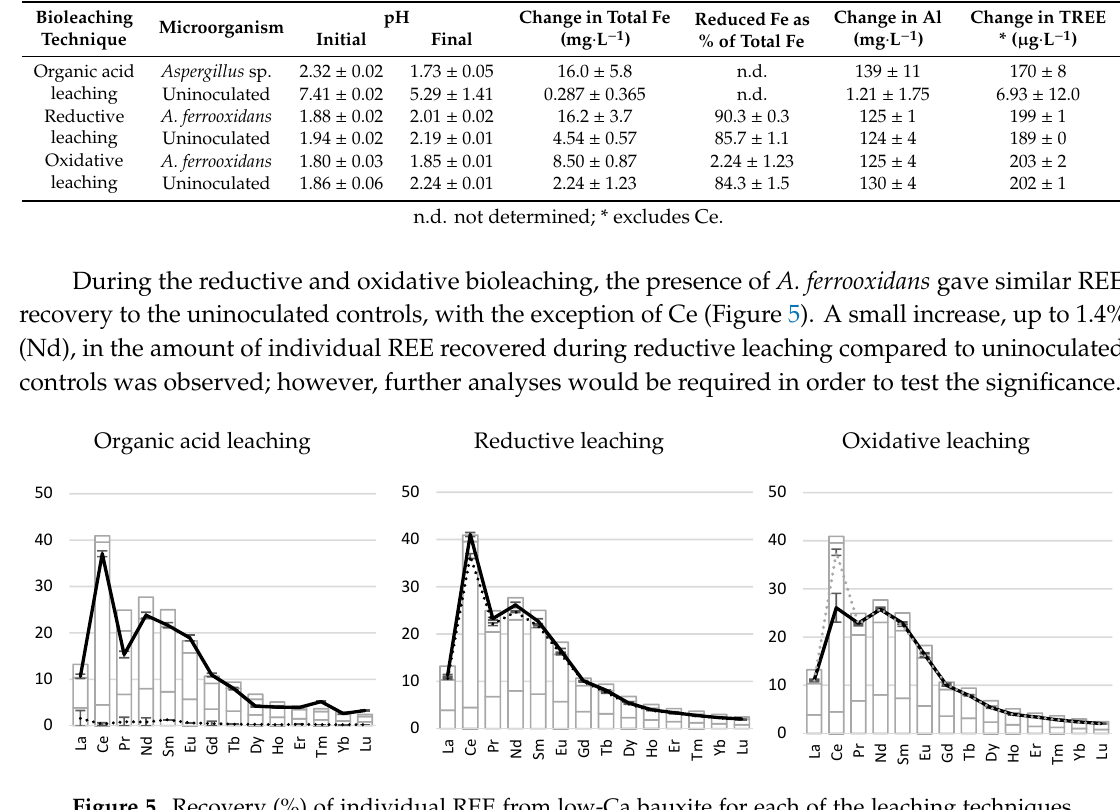
Table 6. Changes in pH, iron, aluminium and TREE concentrations and percentage of reduced iron in final solutions for low-Ca bauxite during organic acid, reductive and oxidative leaching and uninoculated controls. Initial pH was recorded after 1 hour and the final pH was recorded at the end of 7 days of leaching. Total REE (TREE) excludes Ce, due its different behaviour during leaching compared to other REE. Characterisation of starting fluid conditions is shown in Table 3. Errors are one standard deviation of triplicate experiments. Bioleaching Technique